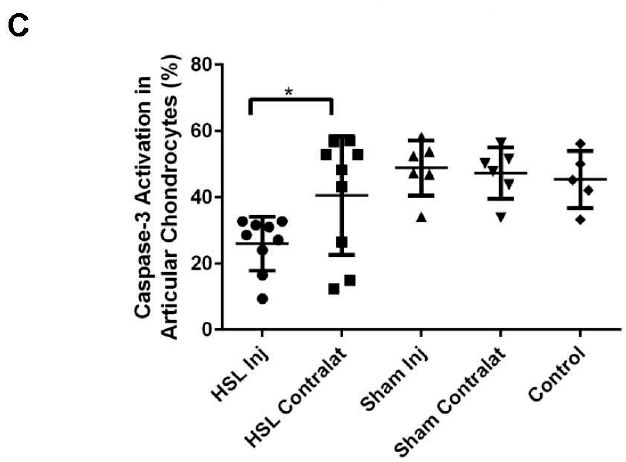
Figure 1. Lubricin-null (Prg 4 − / − ) mouse tibio-femoral joints following intra-articular (IA) injection in vivo with purified human synoviocyte lubricin (HSL; ● ): ( A ) Hematoxylin and eosin stained cartilage shows damage in joints treated and untreated with intra-articular HSL (PRG4). Sub-surface chondrocytes displaying caspase-3 activation are noted in Prg 4 − / − mice, which appear decreased 14 days following intra-articular PRG4. In another group of age matched sham injected Prg 4 − / − mice the qualitative number of chondrocytes displaying caspase-3 activation counterstained with 4,6-diamidino-2-phenylindole, dihydrochloride (DAPI) is not different from control Prg 4 − / − tibio-femoral joints. The untreated contralateral joints ( n = 9) in PRG4-treated mice qualitatively show more caspase-3 activation in sub-surface chondrocytes (scale bar is 50 µ m); ( B ) Box plots showing partial restoration of whole joint coefficient of friction (COF) in Prg 4 − / − mice treated with IA HSL ( ● ), phosphate buffered saline (PBS; ) or no injection (control; ) ; ( C ) Box plots of the same joints show a significant decrease in the percentage of chondrocytes with detectable caspase-3 activation following IA HSL ( ● ) compared to the contralateral joints ( ), * p = 0.024, IA PBS ( ), IA PBS contralateral joints ( ) or no injection (control; ).